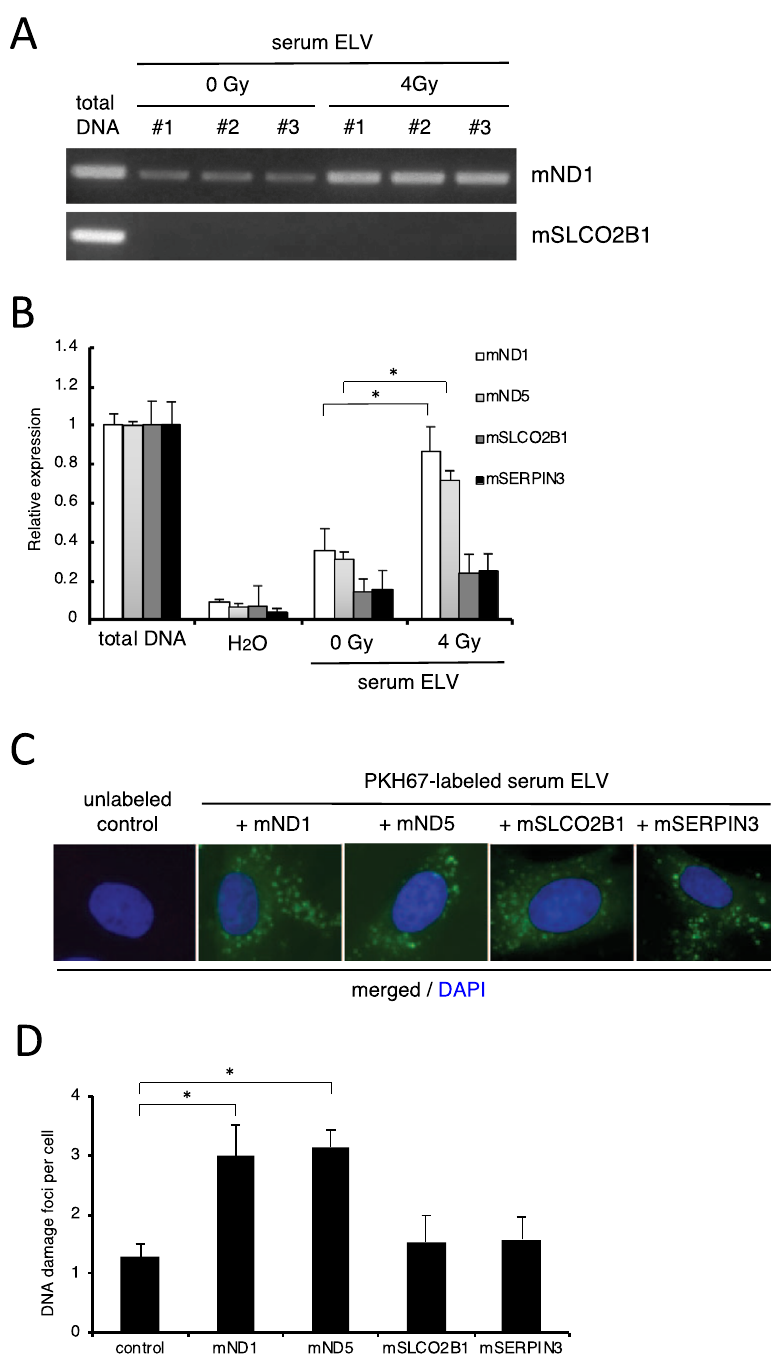
Figure 7. Induction of DNA damage by amplified mouse mtDNA in ELV. ( A ) PCR amplification of mitochondrial mND1 (upper panel) and nuclear mSLCO2B1 (lower panel) in control (0 Gy) mouse serum ELV (n = 3; #1 - #3) and irradiated (4 Gy) mouse serum ELV (n = 3; #1 - #3). Full images of gels are present in Supplementary Fig. S3. ( B ) Quantification of mitochondrial DNA (mtDNA; mND1 and mND5) and nuclear DNA (nDNA; mSLCO2B1 and mSERPINA1) by RT-PCR in control (0 Gy) mouse serum ELV and irradiated mouse serum ELV. Values are represented as mean ± standard error, with significant differences between indicated groups ( * ) calculated by Chi-square test ( p < 0.01). ( C ) Representative image of PKH67 labeled ELV (green) derived from control mouse serum ELV with amplified mtDNA ( + ND1 and + ND5) and amplified nDNA ( + SLCO2B1 and + SERPINA1) up-taken by treated m5S cells, counterstained with DAPI (blue). ( D ) The frequency of DNA damage foci in un-treated cells (control), control mouse serum ELV + ND1, control mouse serum ELV + ND5, control mouse serum ELV + SLCO2B1, and control mouse serum ELV + SERPINA1 treated cells. Values are represented as mean ± standard error, with significant differences between indicated groups ( * ) calculated by Chi-square test ( p <